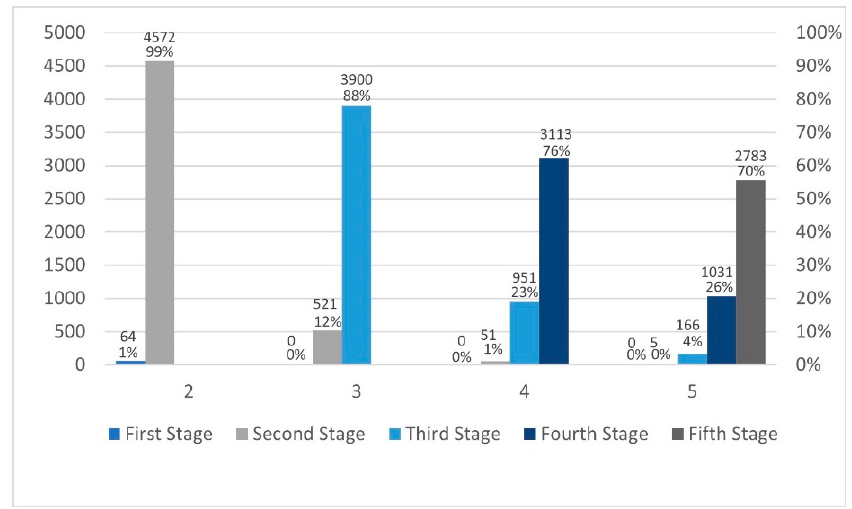
Figure 7. Percent of accepting 𝐻 (cid:2868) occurring at stage i with 500,000